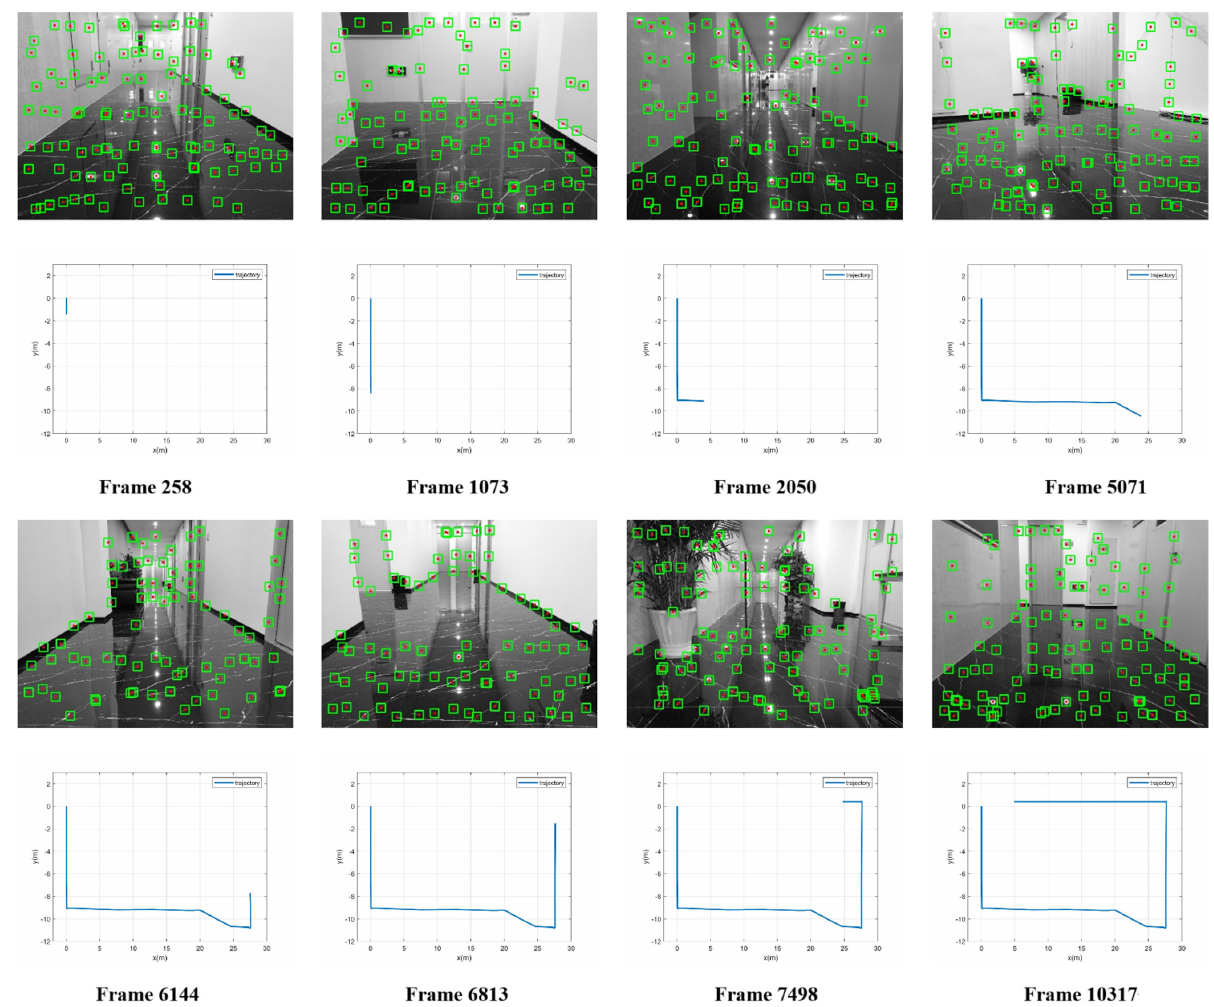
Figure 11. Measured experience map over frames during SLAM process.